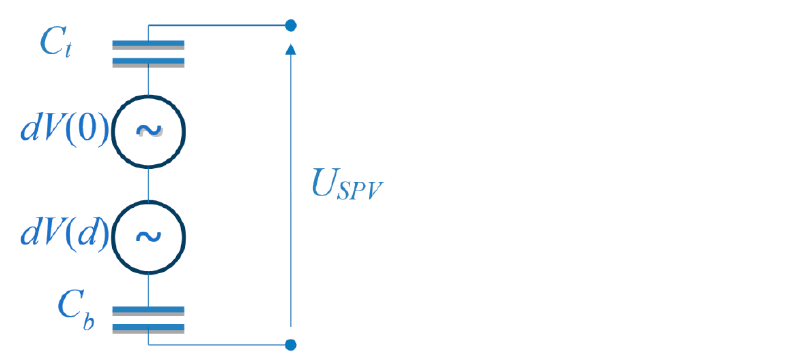
Figure 3. The electrical model of the SPV signal generation system in a situation where both surfaces are signal sources.